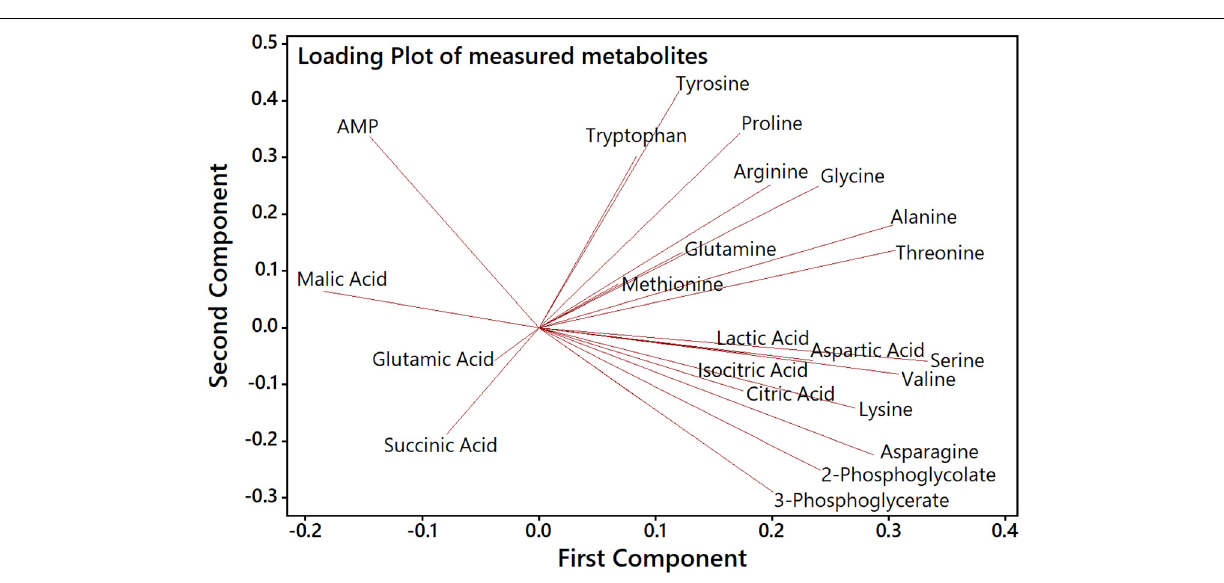
FIGURE 5 | PCA loading plot to analyze the influence of specific metabolites on the first and second component. Each quantified metabolite is represented by a vector, whereby length, angle and direction indicate the contribution of that metabolite to the first and second